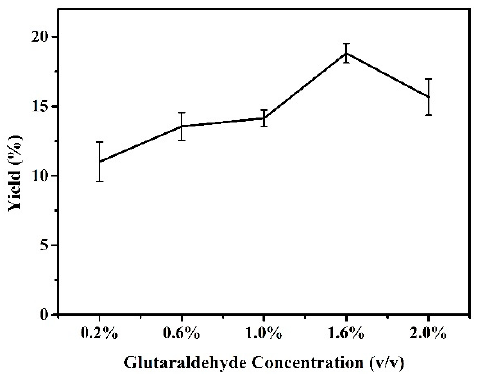
Figure 6. Effect of glutaraldehyde concentration on activity of magnetic CALB CLEAs. Reactions performed with 5 mg magnetic CALB CLEAs and 2 mL of n-hexane containing 0.2 mmol of 2-phenylethanol and 0.4 mmol of vinyl acetate at 50 °C for 72 h.